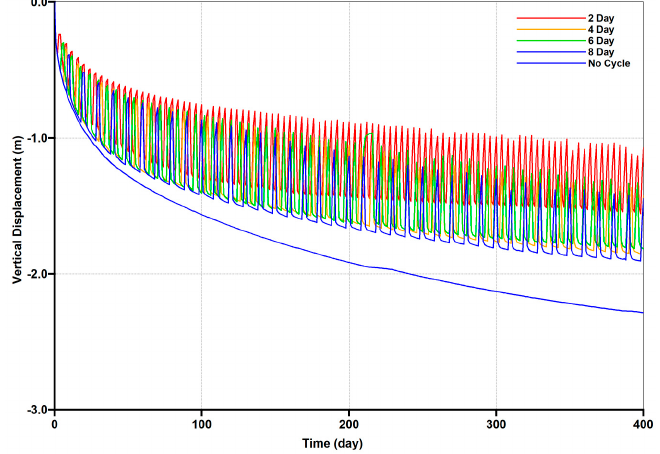
Figure 12. Results of vertical displacement by use of different production time during primary depressurization stage.